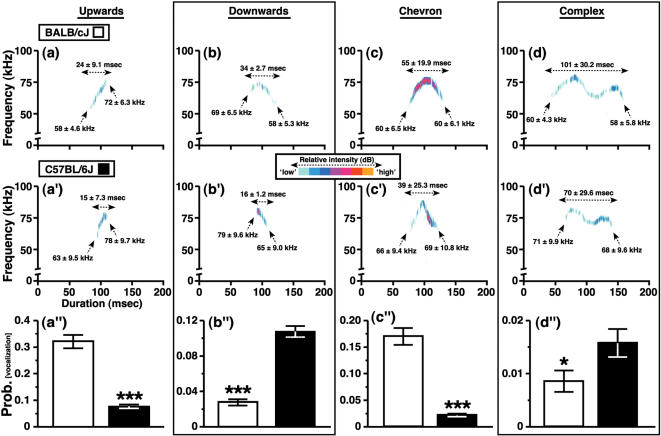

Classification of ultrasonic vocalizations into distinct categories. Representative sonograms and descriptive statistics for different types of USV that were emitted by (a–d) BALB and (a′–d′) B6 mice (see Results for classification criteria). Descriptive statistics (mean±std. dev.) are given for the duration of each call type, as well as the beginning and ending dominant frequency. The USV traces are arbitrarily aligned to the 100-msec demarcation on the abscissa of each sonogram. Intensity changes within each representative vocalization are color-coded. (a″–d″) The production of each USV subtype was strain-dependent (* P<0.05, *** P<0.001 for BALB vs. B6 mice).